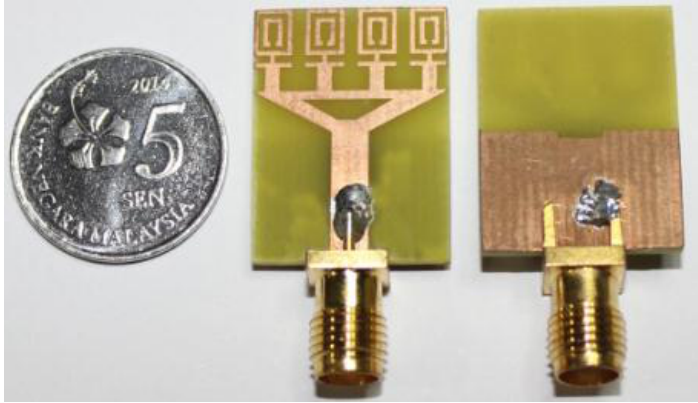
Figure 8. Fabricated prototype of the proposed negative index UWB MTM antenna.